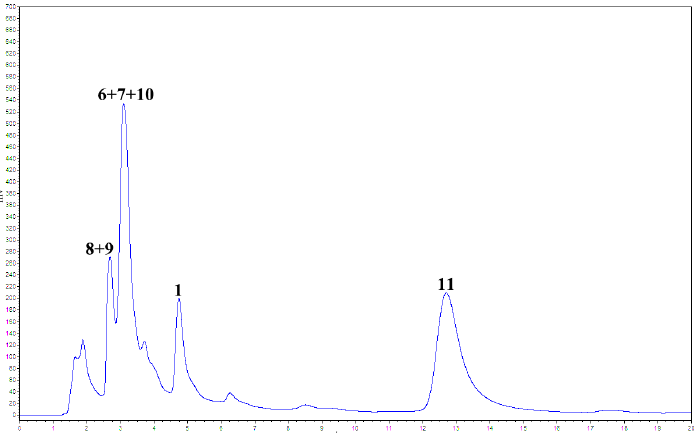
Figure 3. Analysis of resveratrol oxidation products by K 3 Fe(CN) 6 /NaOAc (52% MeOH/H 2 O, λ = 230 nm, 1 mL/min).